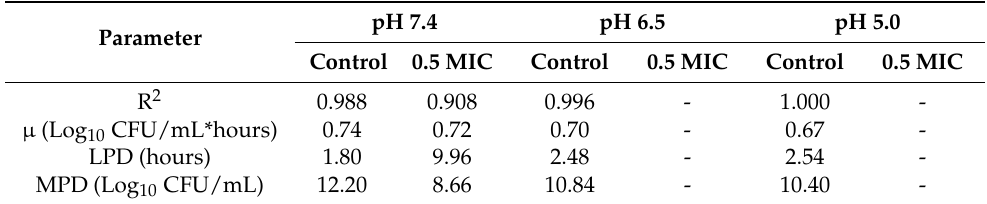
Table 4. Parameters estimated by the Gompertz model for the ATCC 29213 strain at pH 7.4, 6.5, and 5.0.